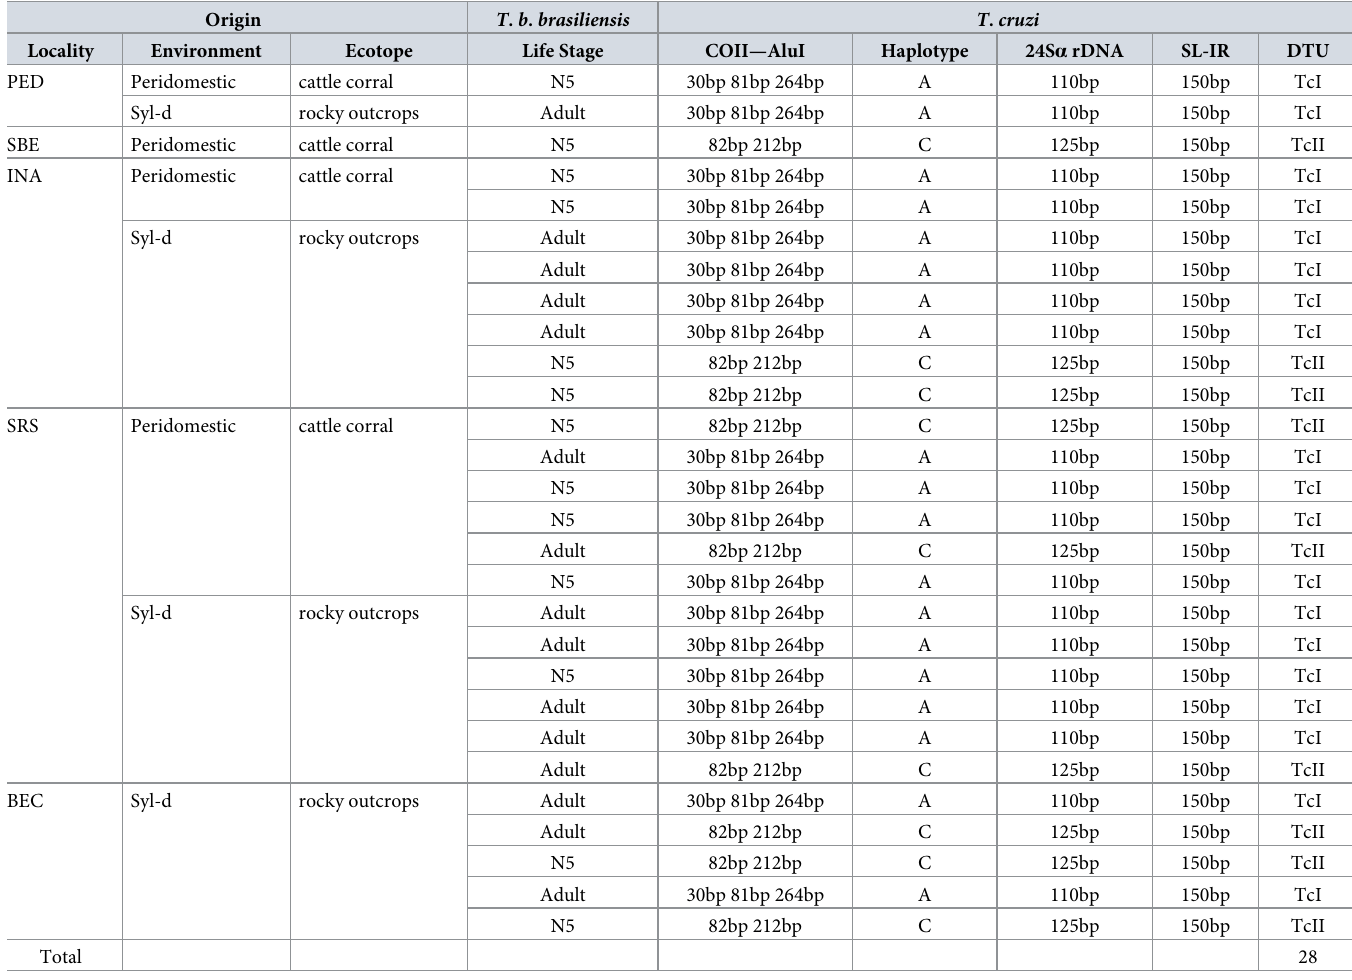
Table 4. List of T . cruzi DTUs isolated from Triatoma b . brasiliensis captured in the peridomestic and sylvatic environments of the localities in the Caico´ municipal- ity, Rio Grande do Norte, Brazil.